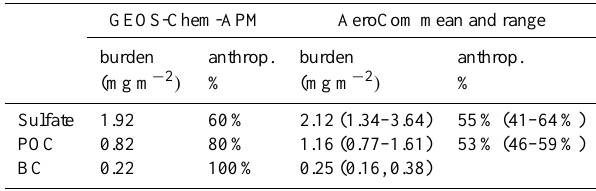
Table 4. Global averaged anthropogenic aerosol burden, and its fraction to total aerosol from GEOS-Chem-APM and from Aero- Com simulations (Schulz et al., 2006). Please note that the GEOS- Chem-APM results are for the year 2006, while AeroCom results are for the year 2000.